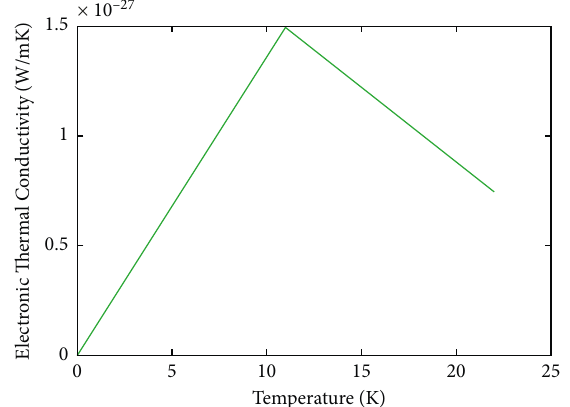
Figure 3: The electronic thermal conductivity of ErNi superconducting state.